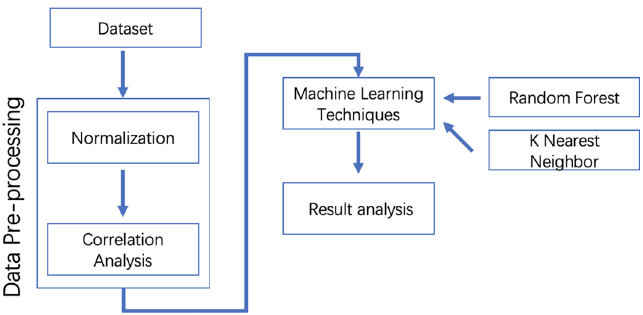
Fig. 1 Research methodology